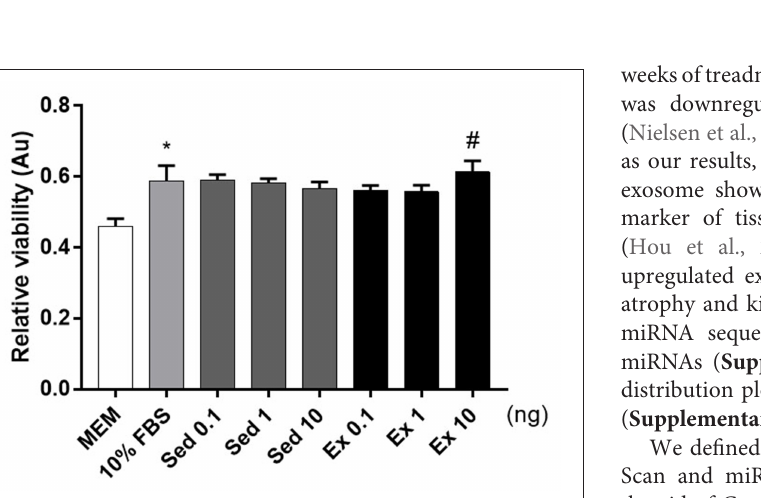
FIGURE 4 | Effects of 4-week, voluntary running wheel exercise-induced EVs on Neuro2A cell viability levels. After 24h of treatment with MEM alone, 10% (v/v) FBS, or 0.1, 1, or 10 ng of EVs from the sedentary or exercised group. * p < 0.05 compared to the MEM control. # p < 0.05 compared to the Sed 10 group. Statistical analysis was performed with the aid of the ANOVA